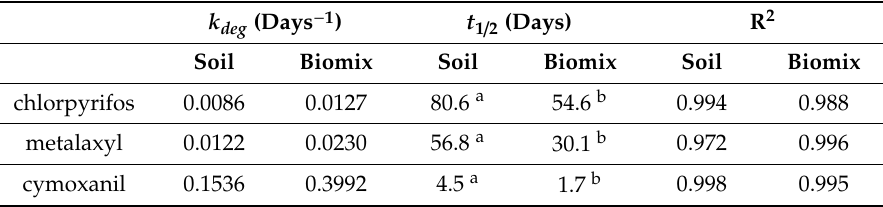
Figure 2. Degradation patterns of the three pesticides in the soil and in the biomix derived by applying first order kinetics to the data from the degradation laboratory experiment (data are the mean of three replicates; standard error even < 2.1% both in soil and biomix samples); R 2 values always significant at p < 0.001 level. Table 4. Degradation parameters of the three pesticides in soil and biomix derived by applying first order kinetics model to the degradation data (data are the mean of three replicates; standard error even < 2.1% both in soil and biomix samples; low case letters represent least significant di ff erences at p < 0.05 in soil and biomix, separately for each